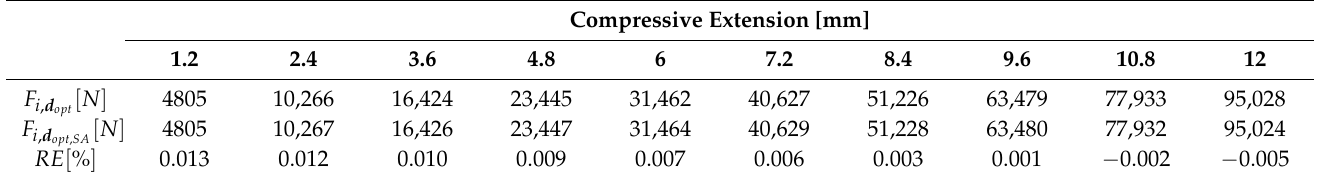
Figure 8. Working characteristics found by the tuned simulated annealing algorithm. Table 11. The working characteristic found by the tuned SA algorithm and its relative error when compared to the desired characteristic.